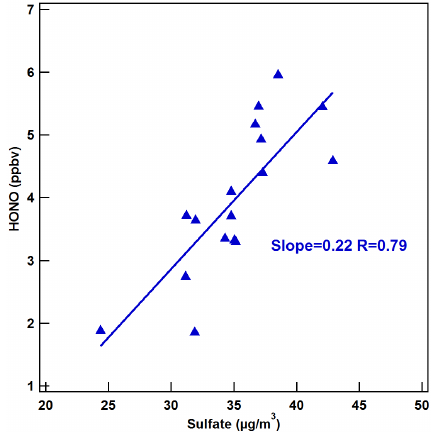
Figure 13. Scatter plot between HONO and sulfate concentration in PM 2 . 5 during the nighttime on the 10